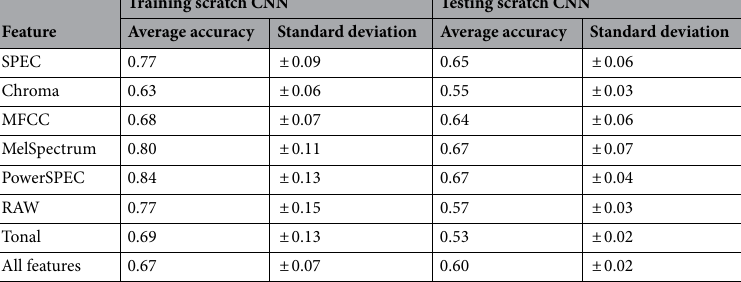
Table 6. Average classification performance per feature for training and testing the convolutional neural network from scratch over 100 training epochs.